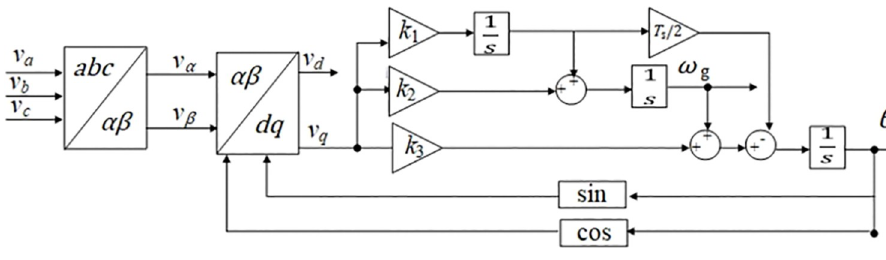
Fig 2. PLL structure of the linear Kalman